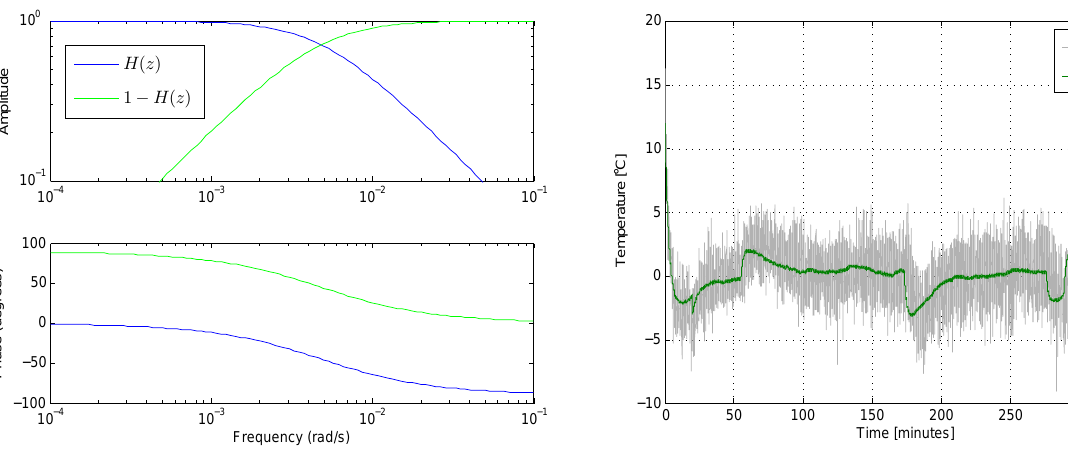
Figure 7: Bode diagram of the complementary filters; the lowpass filter, H ( z ), and the highpass fil- ter, 1 H ( z ). −